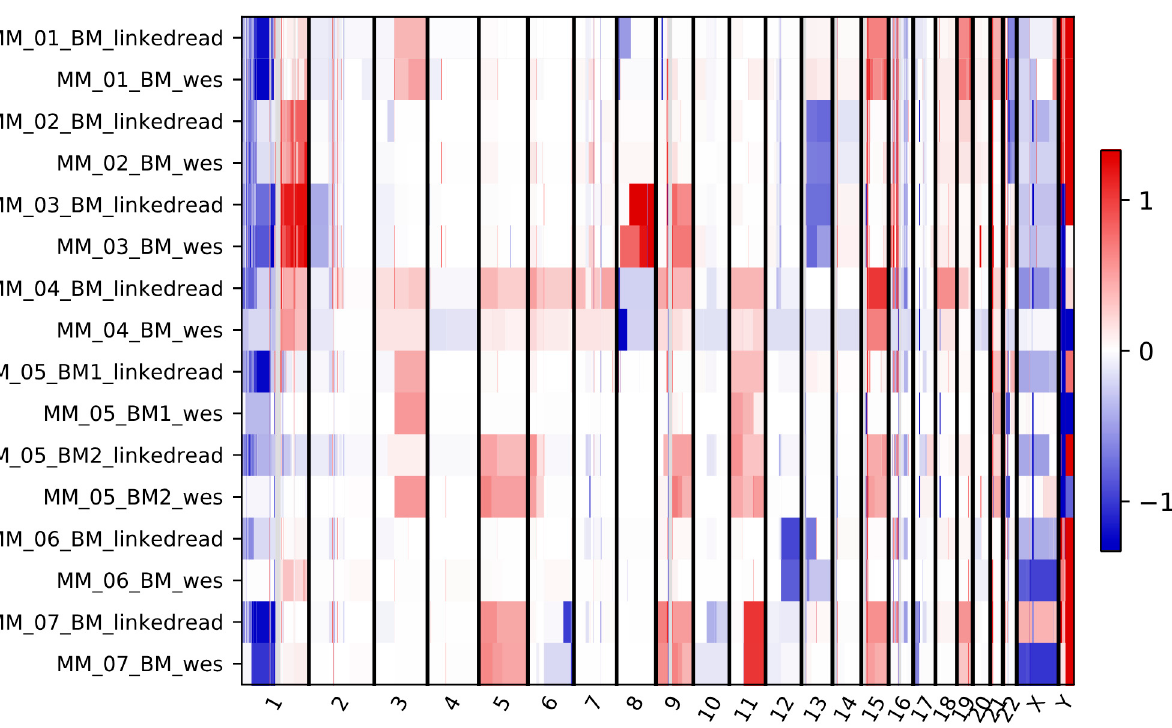
Figure 5. Copy number gain and loss profiles in each chromosome for eight tumor samples sequenced by both linked-read and WES methods. Red and blue represent gain and loss scores in the log2 scale, respectively. The scale − 1 to 1 represent the log2 ratio value of a segment, weighted mean of all bins covered by the segment.